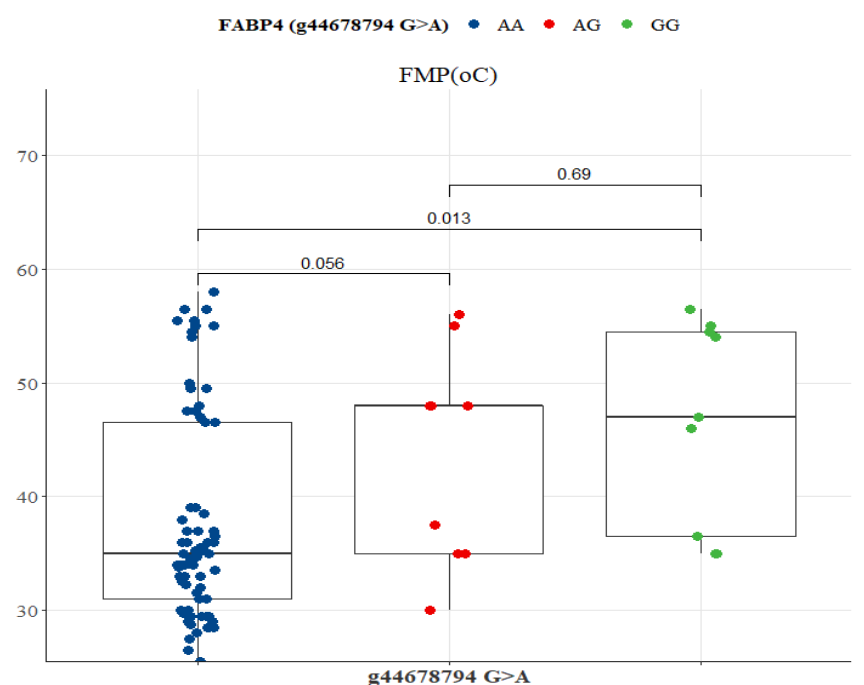
Figure 10. Tukey-adjusted multiple comparisons between a FABP4 SNP locus with FMP of Bowen Genetics Forest Pastoral Angus, Hereford, and Wagyu. The box plot tested the median FMP of AA versus AG, AA versus GG, and AG versus GG genotypes. Significant level set at ( p < 0.05).